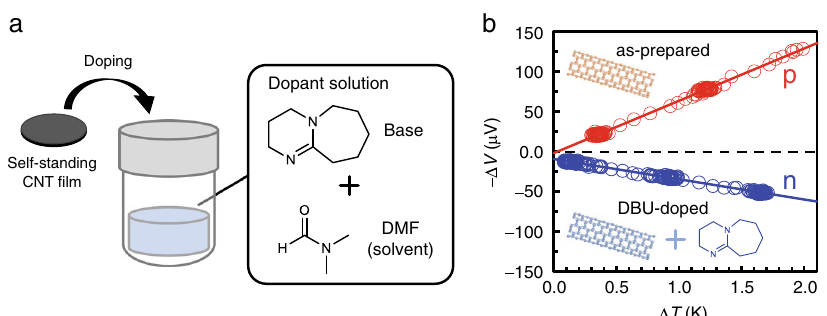
Fig. 2 Fabrication of n-doped CNTs, and the thermopower of doped CNT fi lms. a Schematic of doping by immersing the CNT fi lms in a base solution. b Representative plots of thermopower ( − Δ V ) vs . the supplied temperature difference ( Δ T ) measured using the as-prepared (p-type) and DBU-doped (n- type) fi lms made from EC1.5-CNT. Seebeck coef fi cients ( S ) were determined from the slopes in the plots ( S = − Δ V / Δ T ). Note that the potential of the lower temperature side was de fi ned as ground.